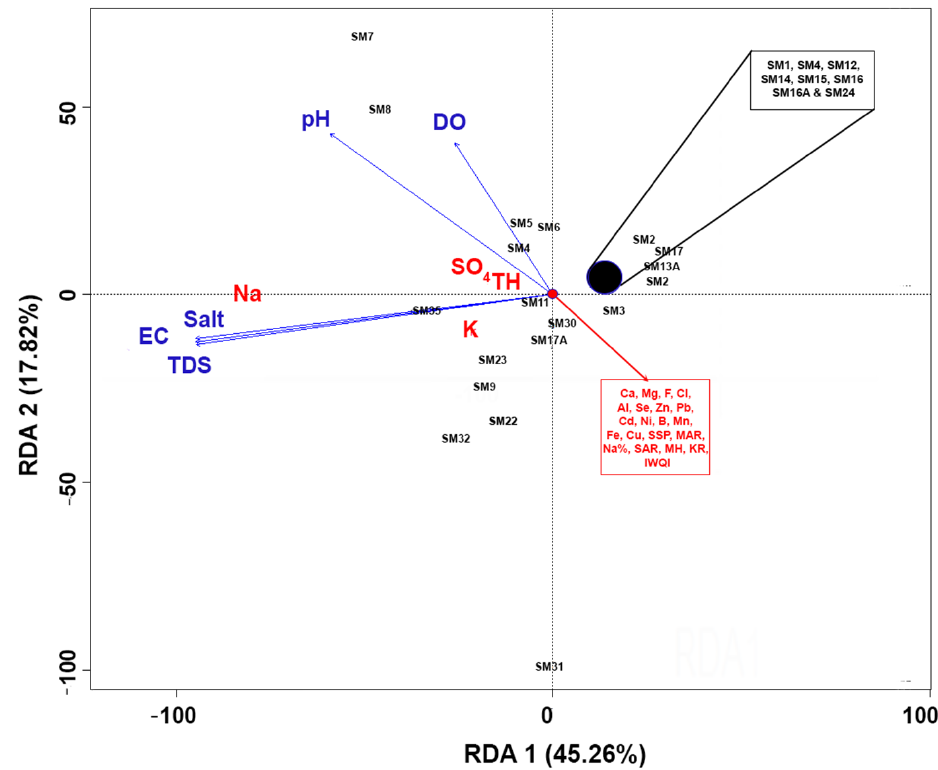
Figure 8. Redundancy analysis diagram showing associations between water physicochemical parameters and toxic metals in the study area.